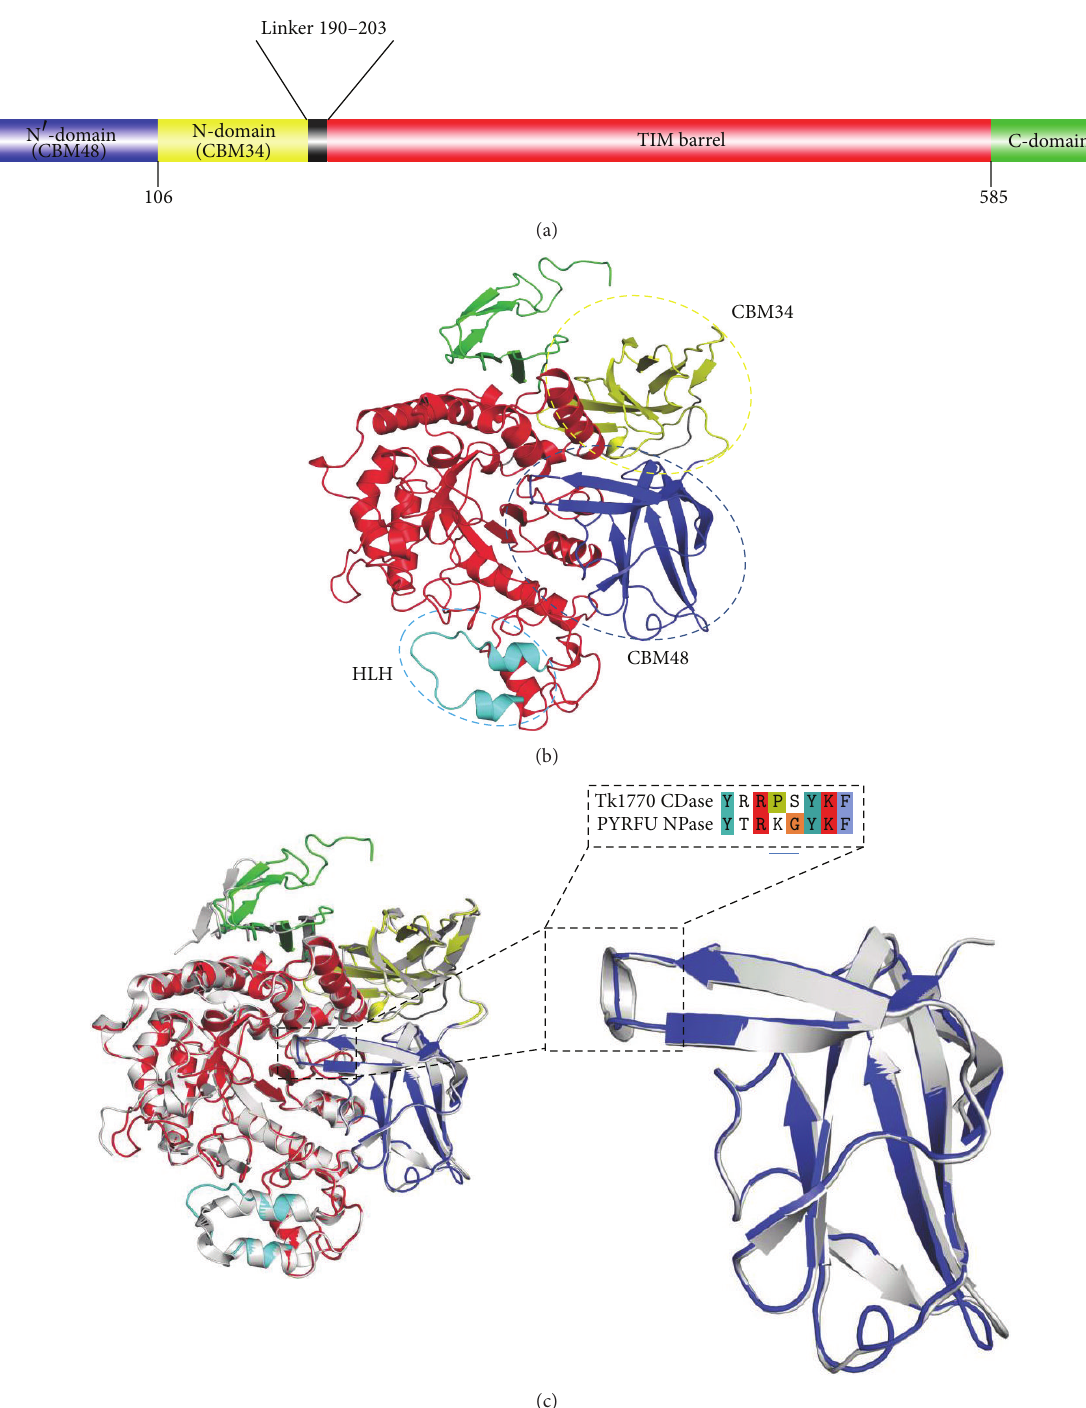
Figure 3: Structural features of Tk1770 CDase. (a) The schematic diagram representing the domain arrangement within Tk1770 made with software DOG (Domain Graph) v2.0 [32]. (b) The homology model of Tk1770 CDase consisting of N 󸀠 - (blue), N- (yellow), catalytic (red), and C-domain (green). The catalytic domain also contains helix-loop-helix (HLH) structure (cyan). (c) Structural alignment of N 󸀠 -domain (CBM48) of Tk1770 CDase (blue) model and template (4AEF) (grey) with an extension of loop into the catalytic site. The sequence alignment between the loops of model and template (4AEF) suggests that the substitution of P91 and S92 in Tk1770 makes its loop